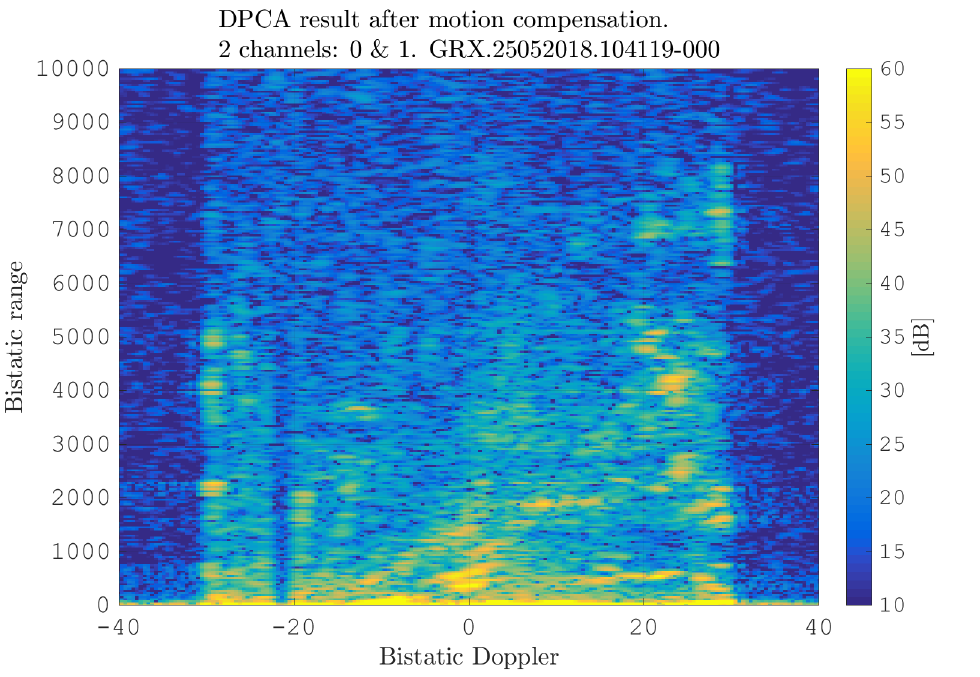
Figure 12. Initial range-Doppler map after DPCA (naive approach): only the motion compensation (11) and DPCA (12) were applied.